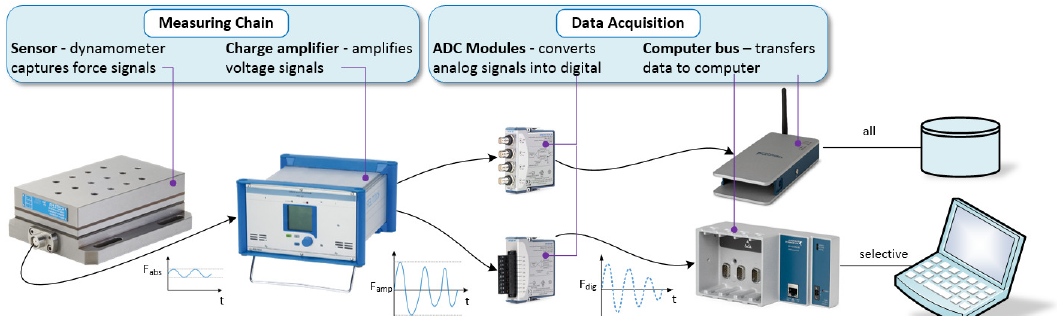
Figure 1. The condition monitoring comprising a dynamometer that measures force and outputs voltage signals (in pC) to a charge amplifier. The amplified voltage (in mV) is a signal sent to analogue-to-digital converter (ADC) modules, the outputs of which are stored and accessed via computer bus devices.